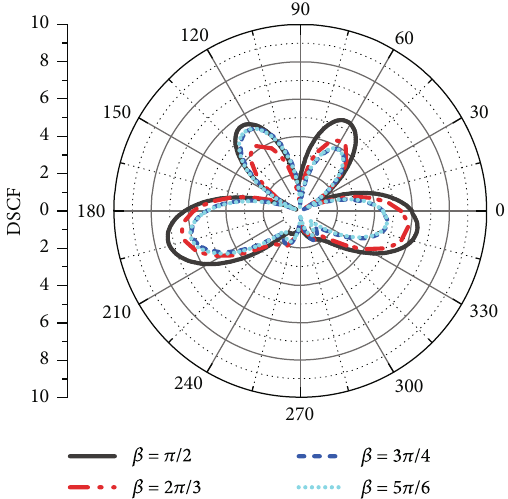
Figure 10: DSCF distribution of the circular hole for di ff erent values of β ( α 0 = 30 ° ).